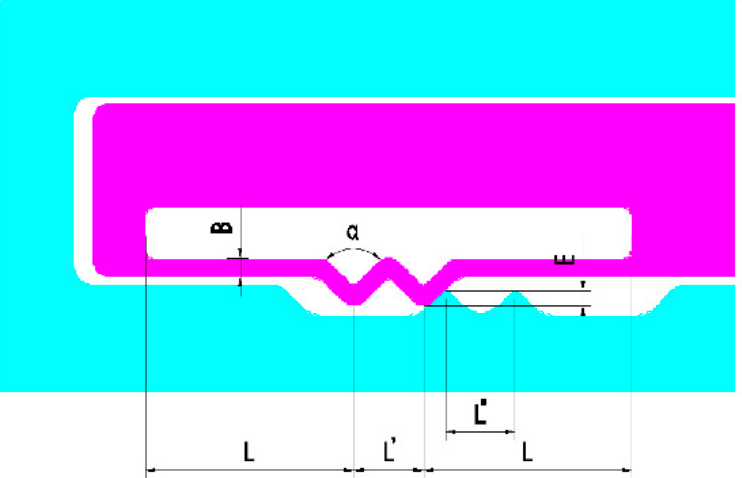
Figure 4. The parameters of elastic-beam delaying mechanism.